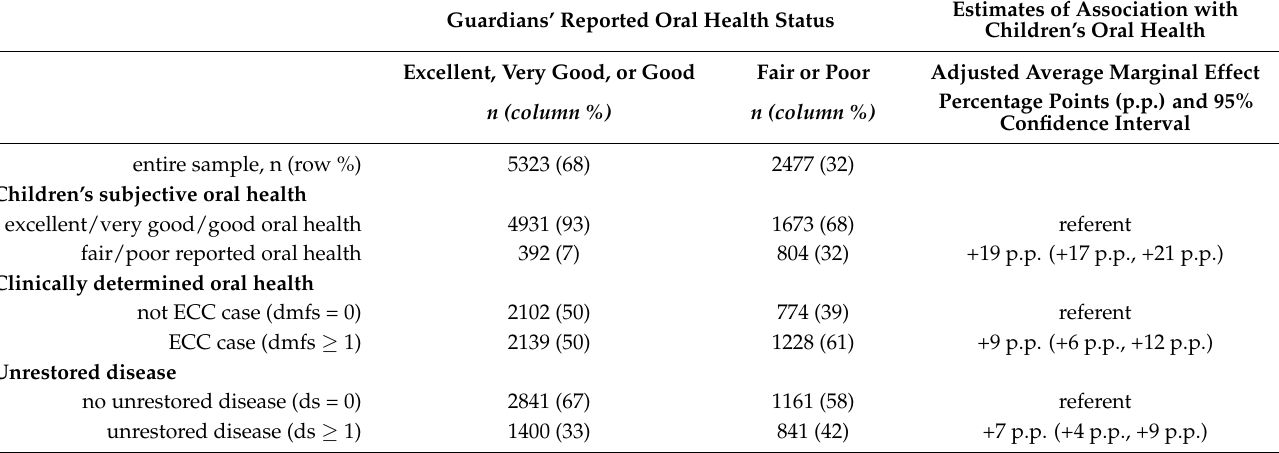
Table 3. Associations between guardian-reported oral health (fair/poor versus excellent/very good/good) and their children’s subjective oral health (fair/poor versus excellent/very good/good) and clinically determined ECC estimated as model-adjusted * average marginal effects and expressed in percentage points (p.p.) and associated 95% confidence intervals (CI). Estimates of Association with Guardians’ Reported Oral Health Status Children’s Oral Health Excellent, Very Good, or Good Fair or Poor Percentage Points (p.p.) and 95% n (column %) n (column %) Confidence